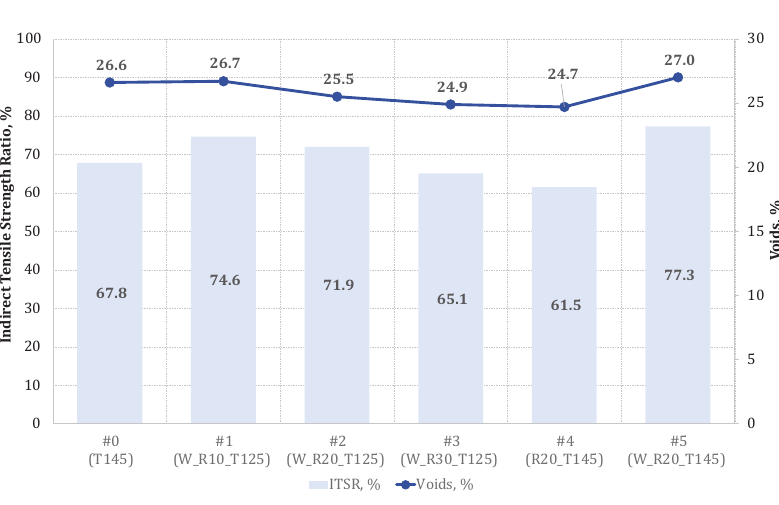
Figure 3. (continuation) Results in terms of mechanical properties of the asphalt: a) particle loss, b) stiffness, c) indirect tensile strength, d) indirect tensile strength